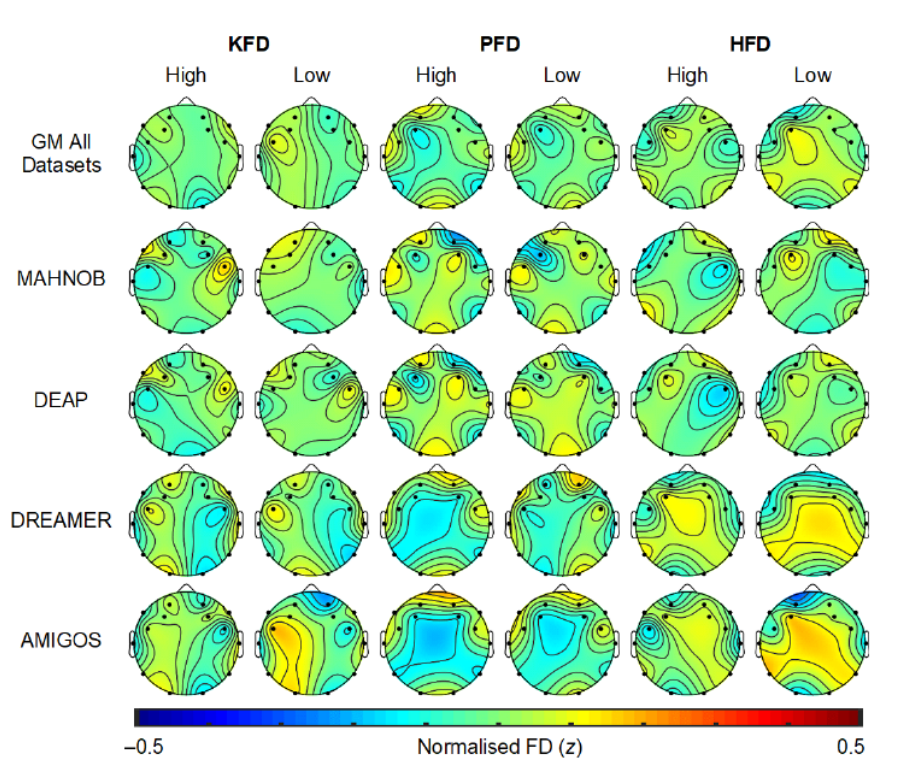
Figure 5. Topography of normalized EEG FD features for high/low arousal. SEED dataset does not have arousal class. GM denotes the grand mean of FD each feature across all the datasets.KFD-Katz’s